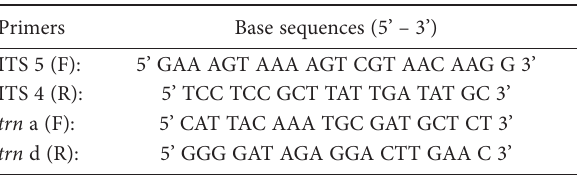
Table 3. The base sequences of the primers used (Taberlet et al., 1991).